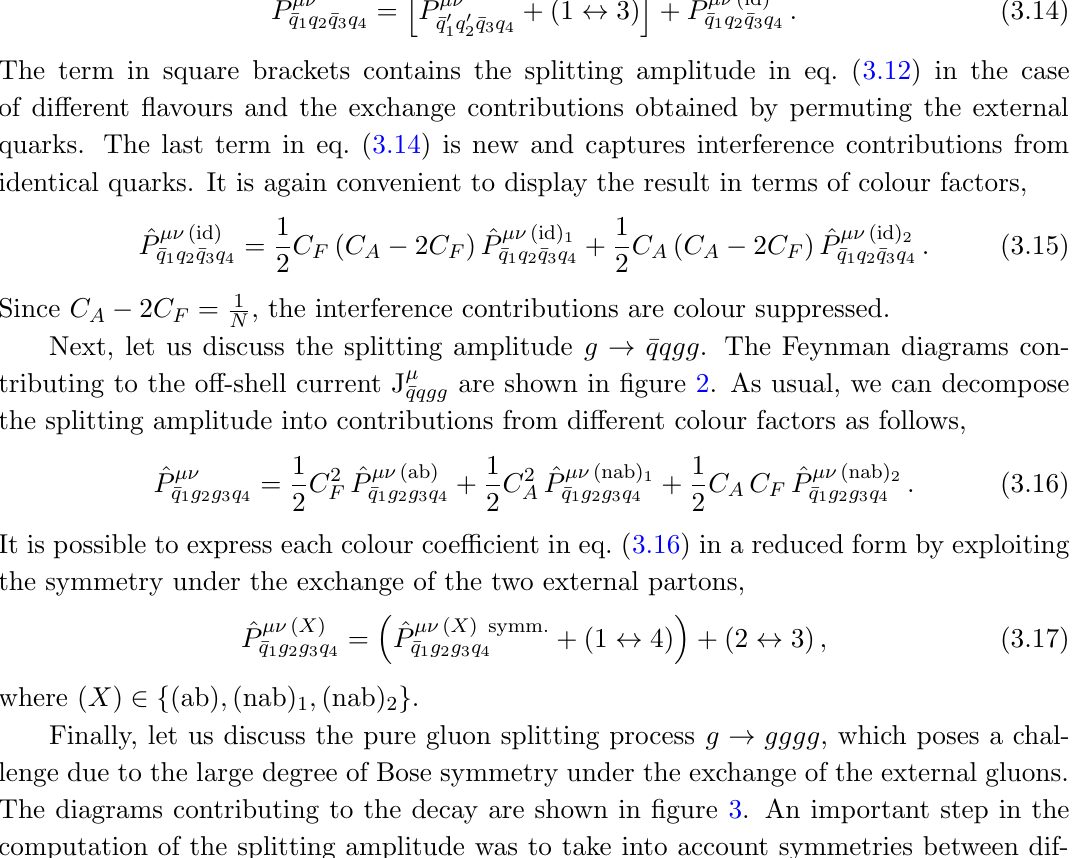
Figure 1 . The diagrams contributing to the o(cid:11)-shell current g ! (cid:22) q 0 quarks we also need to include diagrams where the anti-quarks q 1 and q 3 are